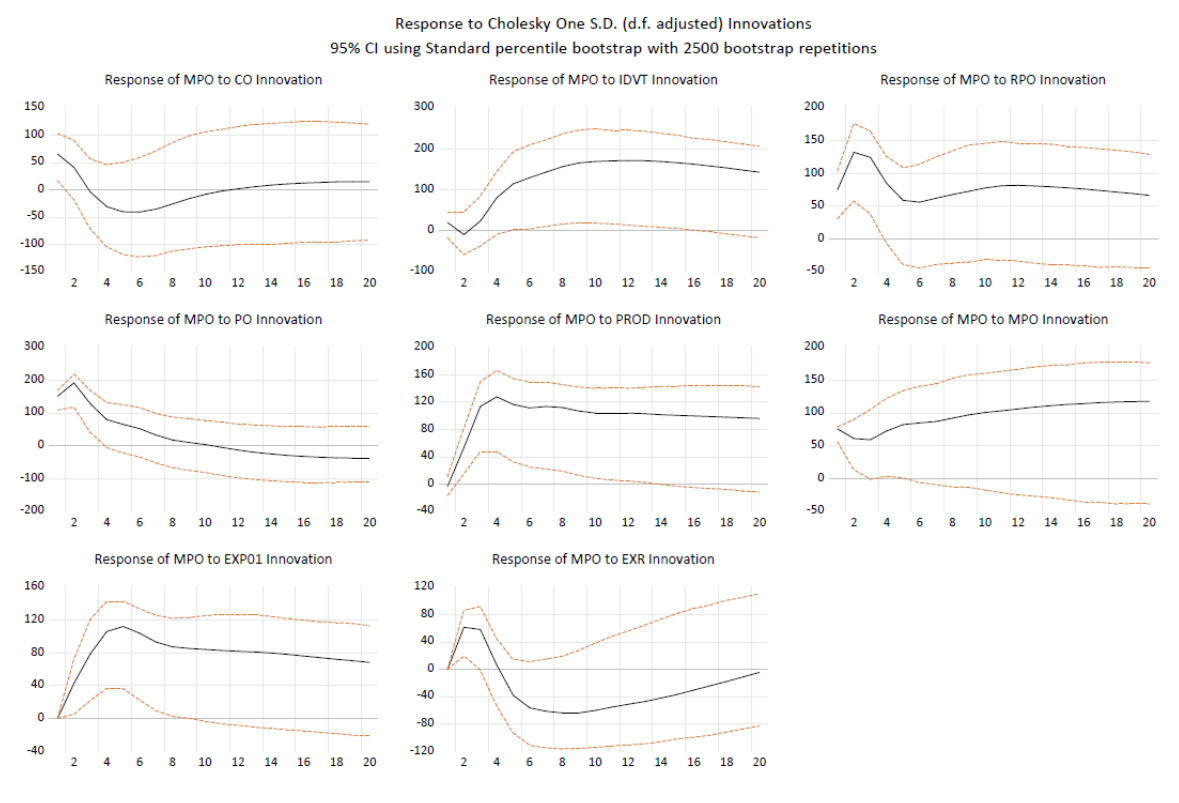
Figure 6. Impulse response after replacing SBO with RPO.